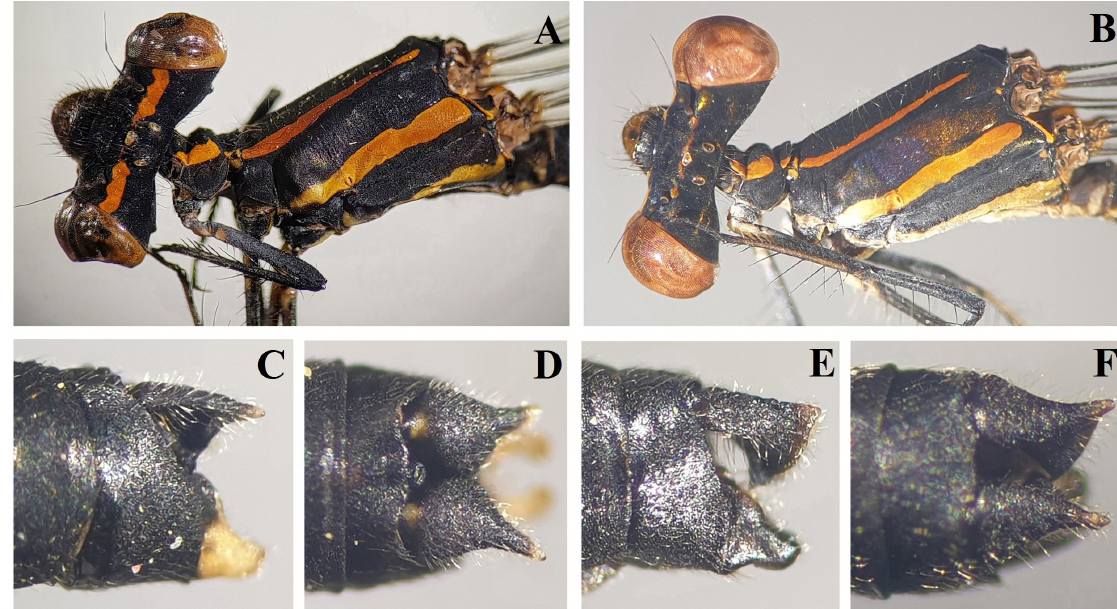
Fig. 9. Structures of Prodasineura Cowley, 1934 spp., males, holotypes. A, C–D . P. kong sp. nov., ZCDTU 2019071811-ODO. B, E–F . P. lancastrei sp. nov., ZCDTU 2019051212-ODO. A–B = head and thorax, lateral view; C, E = appendages, lateral view; D, F = appendages, dorsal view. Images not to